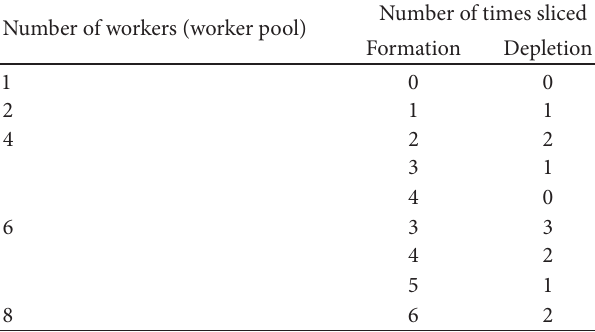
Table 1: Loop slicing